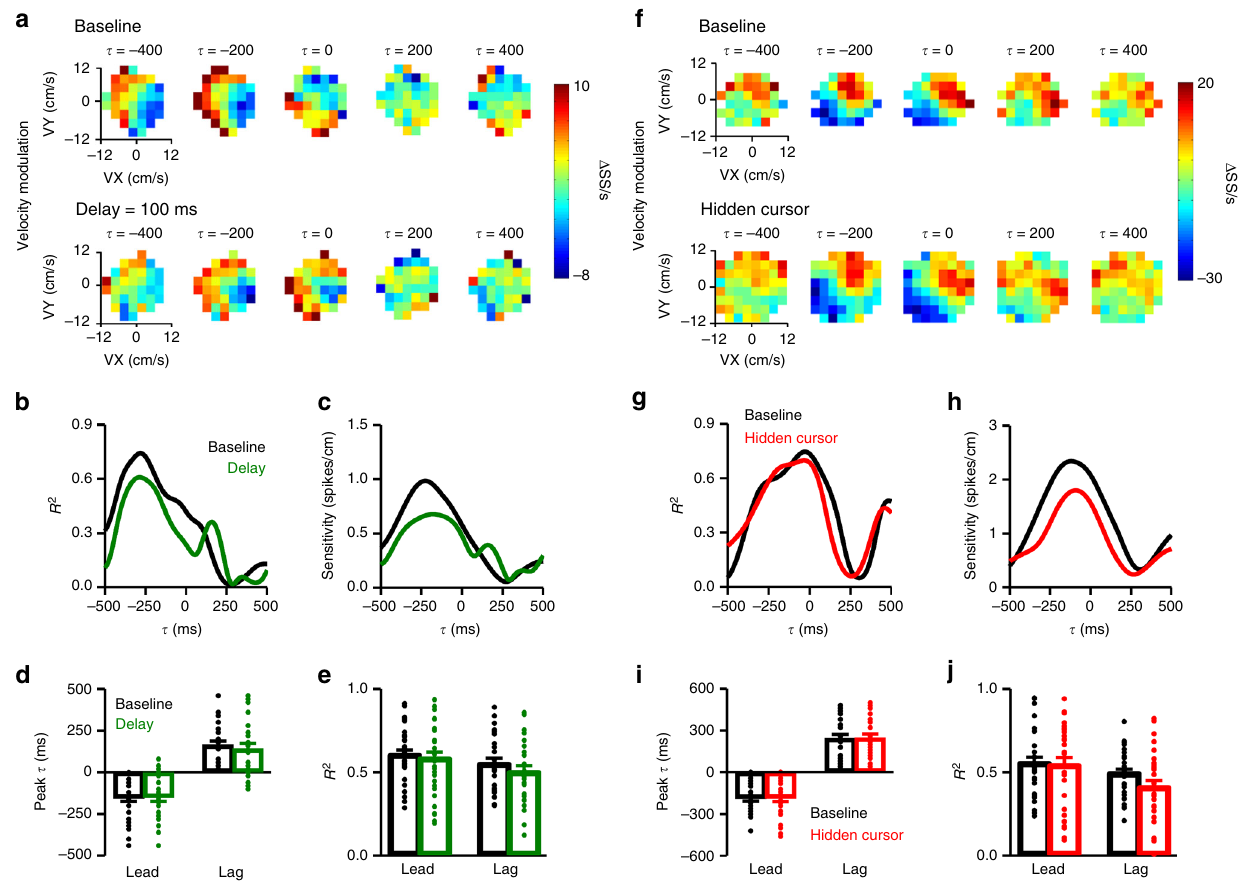
Fig. 8 Kinematic encoding is unaffected by visual feedback manipulations. a Firing maps for an example Purkinje cell with lead SS velocity modulation in both baseline (top row) and 100 ms delay (bottom row) conditions. Each map indicates SS modulation at a speci fi c lead (negative τ ) or lag (positive τ ). b and c R 2 and sensitivity pro fi les, respectively, for the example Purkinje cell shown in a with signi fi cant encoding of manipulandum velocity in both baseline (black line) and 100 ms delay (green line) conditions. d Average peak timing of both lead and lag SS encoding of manipulandum kinematics did not change between baseline and delay conditions ( F (1,107) = 0.15, p = 0.70, ANOVA). e Average encoding strength ( R 2 ) of lead and lag encoding for all Purkinje cells with signi fi cant encoding of kinematics ( F (1,107) = 0.47, p = 0.71, ANOVA). f Firing maps for an example Purkinje cell with lead SS velocity modulation in both baseline (top row) and hidden (bottom row) conditions. Each map indicates SS modulation at a speci fi c lead (negative τ ) or lag (positive τ ). g and h R 2 and sensitivity pro fi les, respectively, for the example Purkinje cell shown in f with signi fi cant encoding of manipulandum velocity in both baseline (black line) and hidden cursor (red line) conditions. i Average peak timing of both lead and lag SS encoding of manipulandum kinematics in baseline and hidden cursor conditions ( F (1,113) = 0.01, p = 0.93, ANOVA). j Average encoding strength ( R 2 ) of lead and lag encoding for all Purkinje cells with signi fi